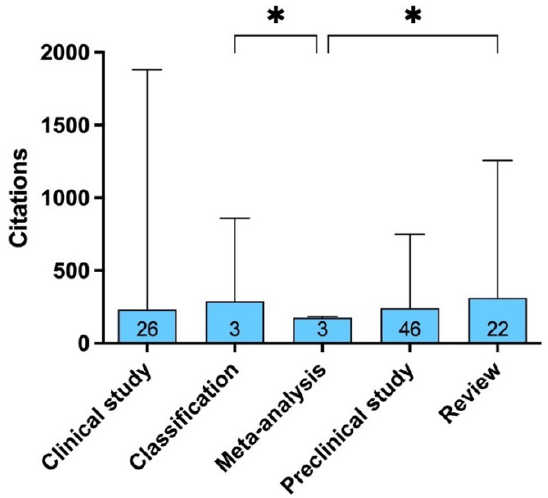
Figure 5. Theme distribution of articles . Bar graph showing the median number of citations (and maximum) for the most-cited articles according to the theme distribution of articles (number of ar- ticles at the bottom of the bar).